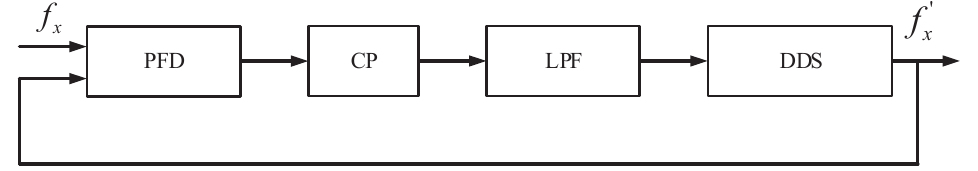
Figure 8. The structure of the accurate frequency measurement module using closed-loop feed- back